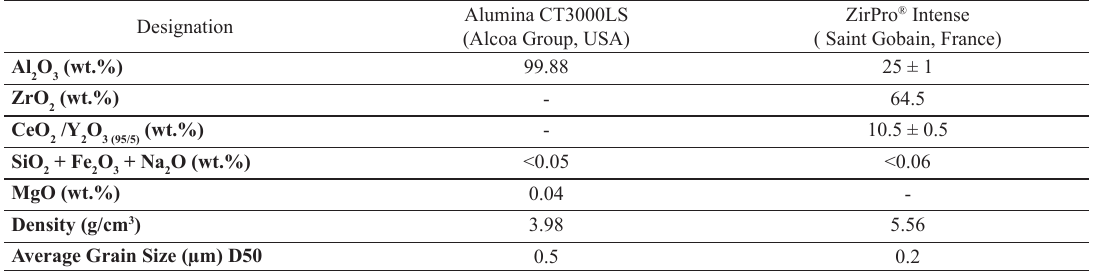
Table 1. Specifications of the starting powders used in this investigation (Manufacturer’s